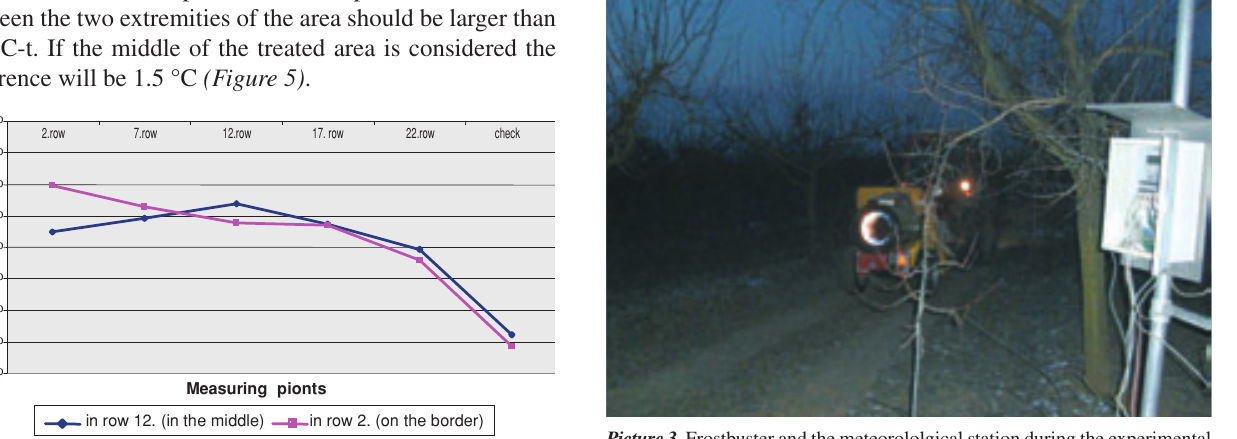
Figure 5. Effect of moving to and fro of the machine at the margin (2 nd row) or at the middle (12 th row) of the plantation on different parts of the area protected /Siófok, 2011. Febr. 23-24/